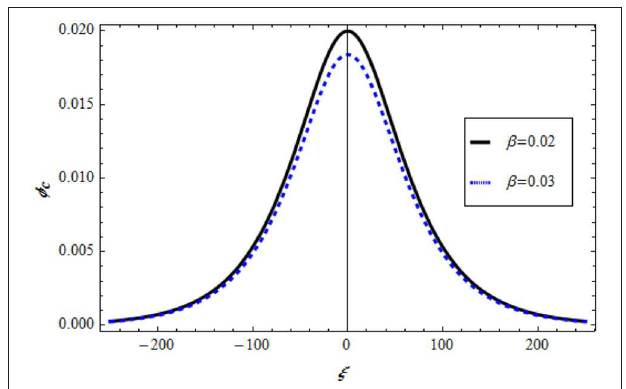
FIGURE 4 | Variation of shock φ c against χ for β L 0.5. =